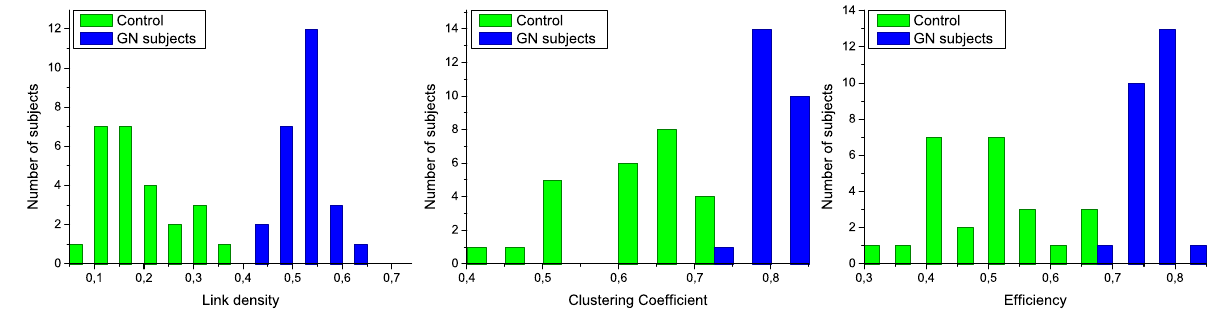
Figure 3. Analysis of the structural characteristics of networks for control subjects (green) and patients (blue). The three plots represent the histograms for (left) link density, (center) clustering coefficient, and (right) efficiency-see text for